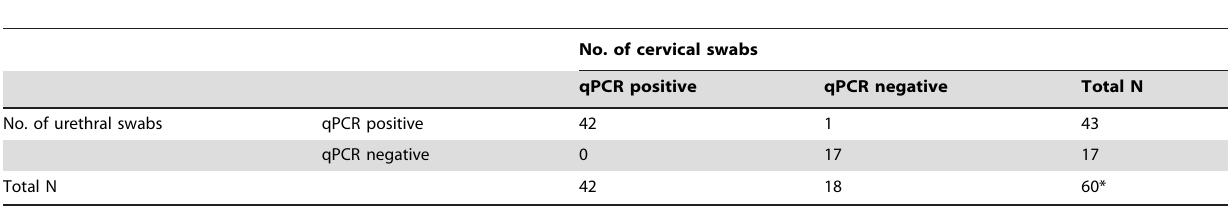
Table 5. Distribution of ureaplasma positive and negative samples in 60 paired urethral and cervical swabs collected from the same woman as determined by